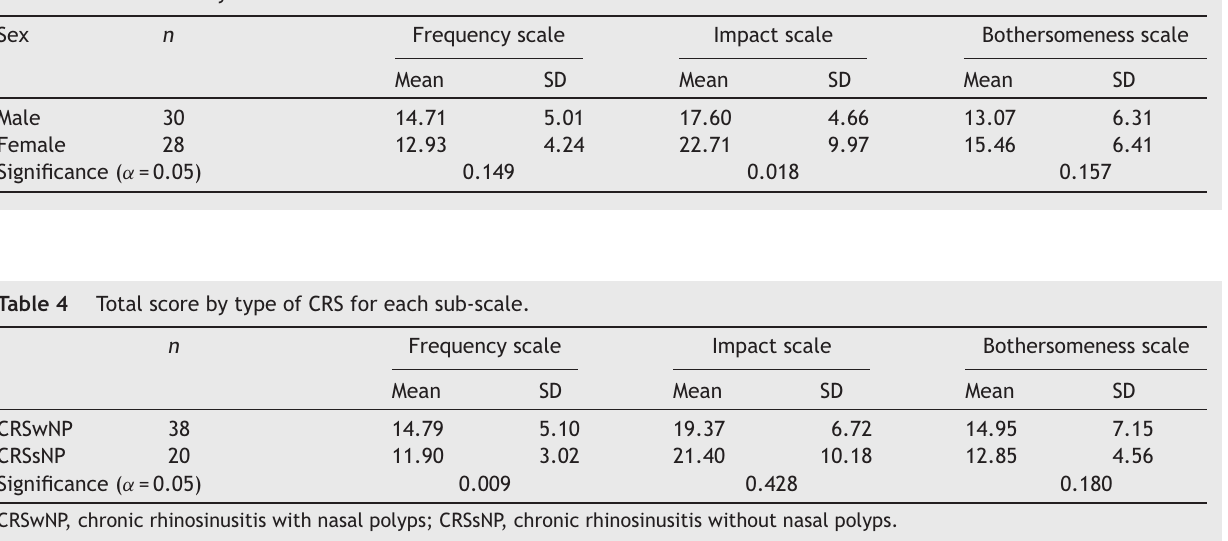
Total score by sex for each sub-scale. Sex n Frequency scale